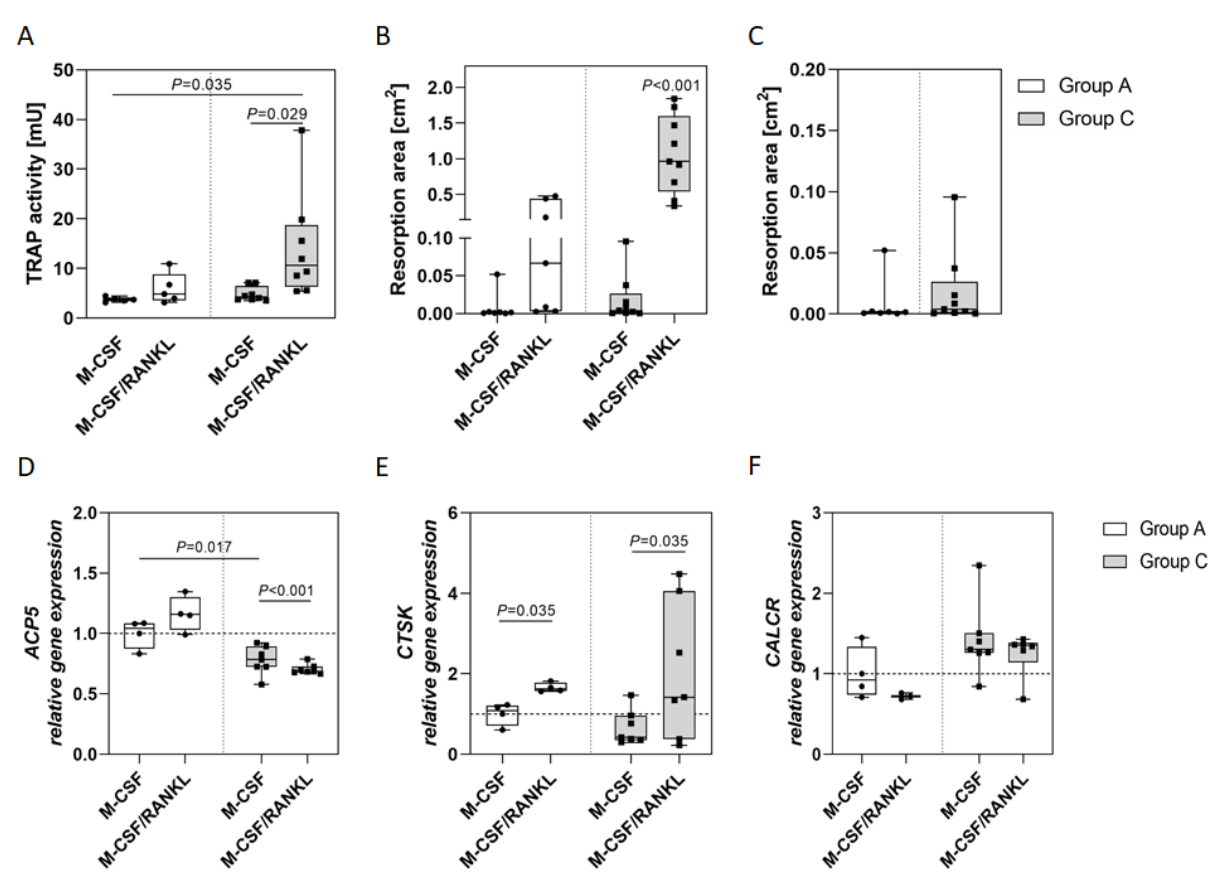
Figure 1. TRAP and resorption activity and gene expression of PBMC derived either from arthritis (group A) or Charcot patients (group C), respectively. ( A ) TRAP activity was determined in PBMC either treated with M-CSF only or with M-CSF and RANKL after 14 days of culture (group A: n = 5; group C: n = 8). ( B ) Resorption activity was performed by culturing PBMC on a cell-derived calcium phosphate matrix. After 14 days of culture, calcium phosphate was stained black by von Kossa silver staining. Wells were scanned and black (calcium phosphate) and white (resorbed) areas were quantified (group A: n = 7; group C: n = 9). ( C ) Comparison of initial resorption activity of both patient groups after M-CSF only treatment showing higher initial resorption activity without RANKL in group C than in group A ( p = 0.48). ACP5 ( D ), CTSK ( E ) and CALCR ( F ) expression were determined by qPCR after 14 days of culture (group A: n = 4; group C: n = 7). Results are shown relative to GAPDH expression and were normalized to group A M-CSF and were calculated using the CT method. All data are provided as median with interquartile range and min/max values; statistical analyses for ( A , B , D – F ) were performed using ANOVA and Tukey post-hoc test; statistical analysis for ( C ) was performed using t test.